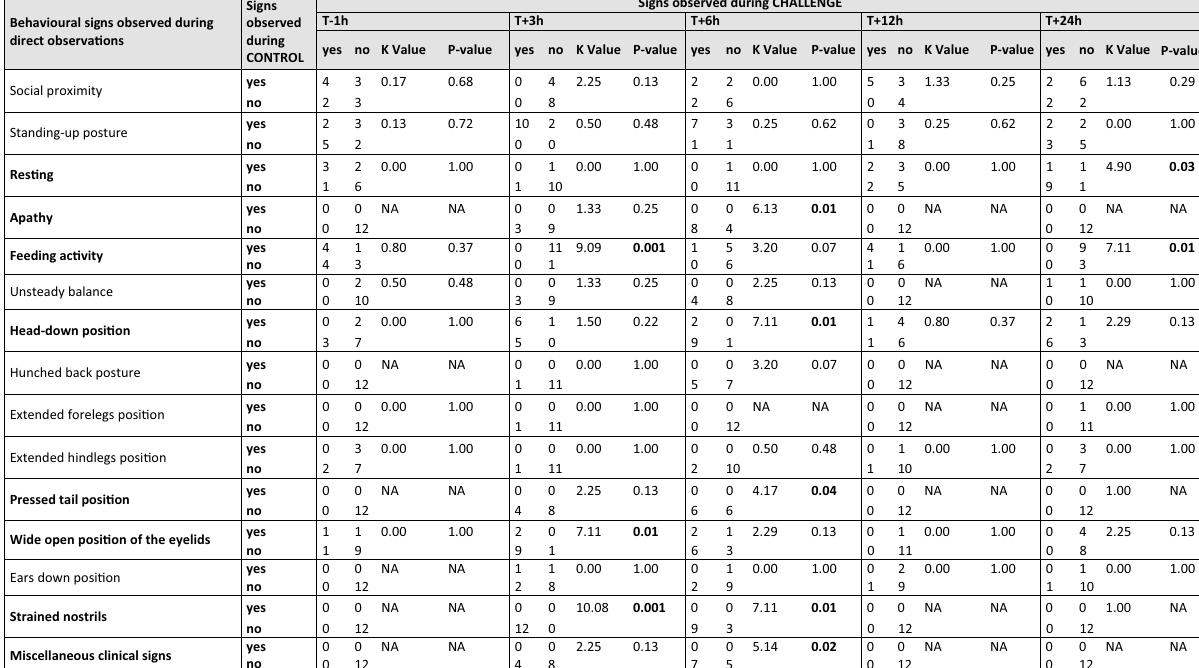
Table 2. Concordance of behavioural signs in 12 Holstein cows under LPS CHALLENGE and CONTROL situations at T−1 h, T + 3 h, T + 6 h, T + 12 h and T + 24 h after intravenous injection of LPS (0.5 µg/kg of BW) (or equivalent time in the CONTROL situation). McNemar tests served to check whether cows had changed their behaviour between the two situations (change exists when p ≤ 0.05). For instance, regarding apathy at T + 6 h, 8 cows that were not apathetic in the CONTROL situation became apathetic in the CHALLENGE situation, while the 4 other cows were not apathetic in both the CHALLENGE and CONTROL situations ( p = 0.01). NA corresponds to no cows changing their behaviour between the two situations. Significant values are in